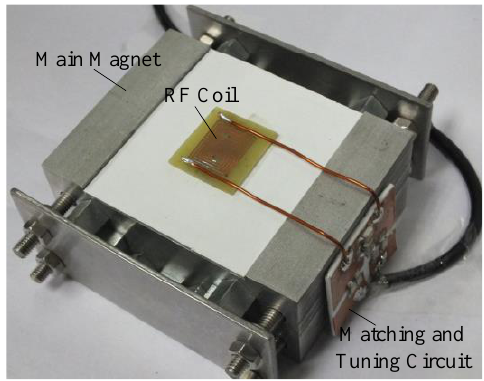
Figure 3. The portable NMR